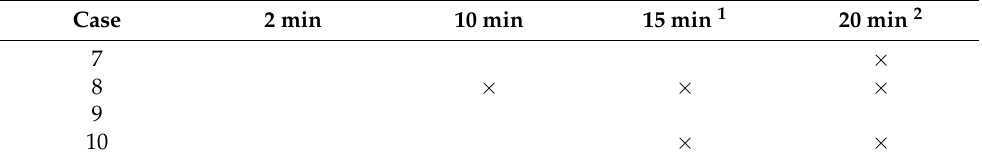
Table 2. Record of sample vials with crosslinker that cracked (use of “ × ”) upon quenching in liquid nitrogen, per experiment for gas chromatography and per time of